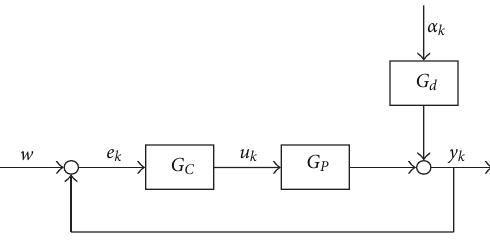
Figure 4: Example of GPS frames (a) and MADS frames (b) P k = { x k + Δ m k d : d ∈ D k } = { p 1 , p 2 , p 3 } for di ff erent values of Δ m k = Δ six figures, the mesh M k is the intersection of all lines.